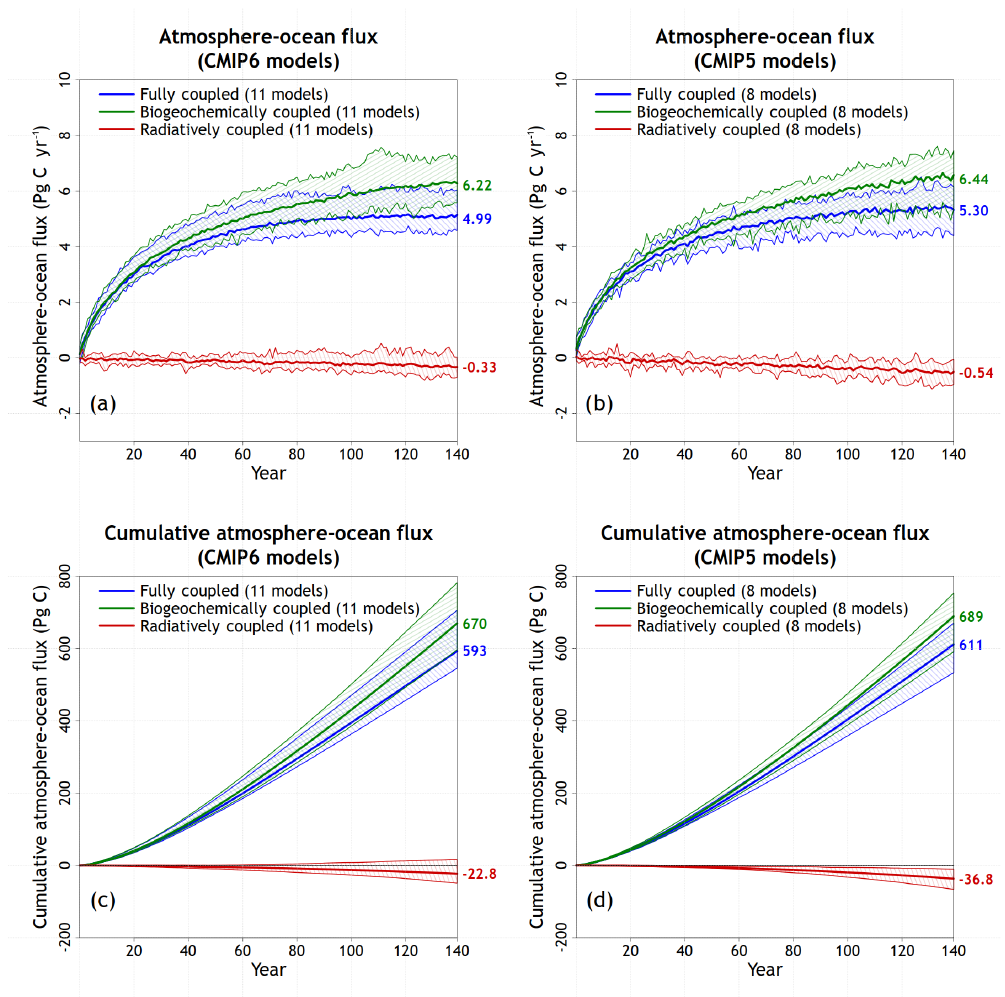
Figure 3. Model mean values and the range across models for annual simulated atmosphere–ocean CO 2 flux (a, b) and their cumulative values (c, d) for participating CMIP6 (a, c) and CMIP5 (b, d) models from the fully, biogeochemically, and radiatively coupled versions of the 1pctCO2 experiment. Individual CMIP6 model results are shown in Fig.